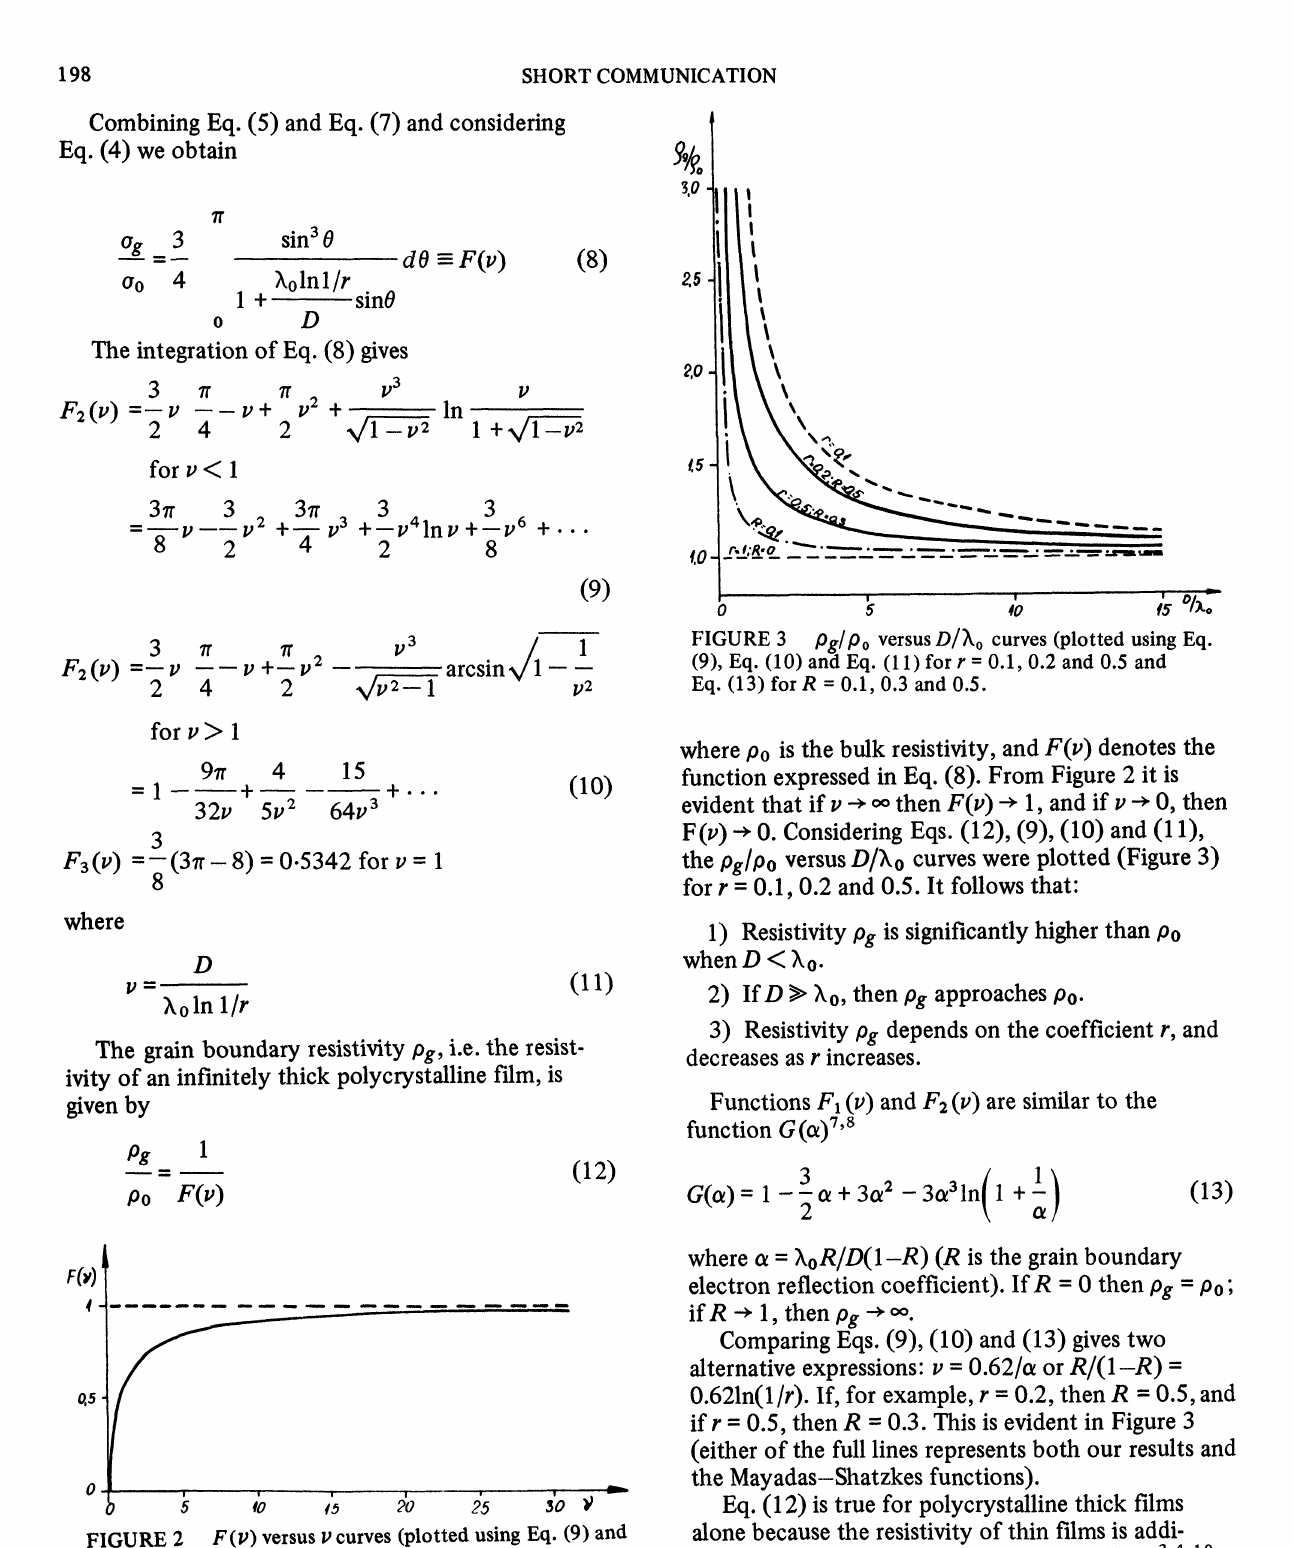
FIGURE 2 F(1)) versus/2 curves (plotted using Eq. (9) and Eq. (10)).